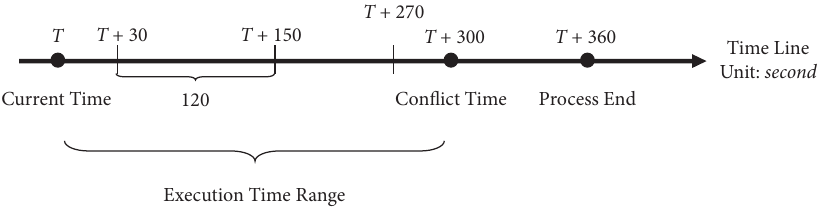
Figure 6: The diagram of the action execution time: the timeline is not